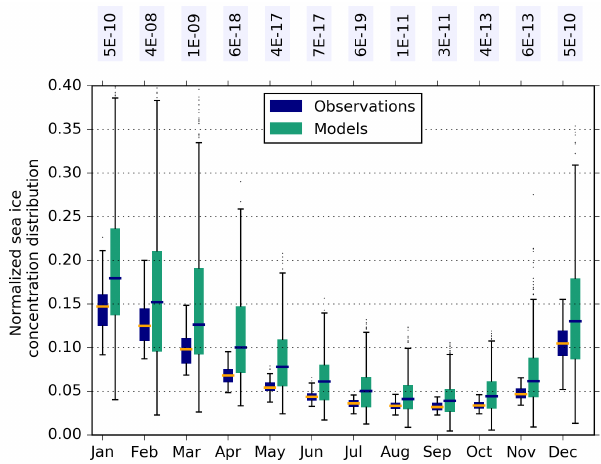
Figure 6. The 10–20% bin from the normalized sea ice concentra- tion distribution for each month, where boxes contain all years from 1992 to 2014 from (blue) the three sets of satellite observations and (green) the 40 CMIP5 models. Box plots as in Fig. 1. Annotated text is the p value calculated from a Kolmogorov–Smirnov test, which represents the confidence that the two populations come from the same